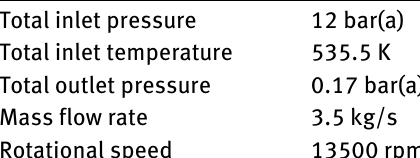
Table 6: Design parameters for the centripetal stage.